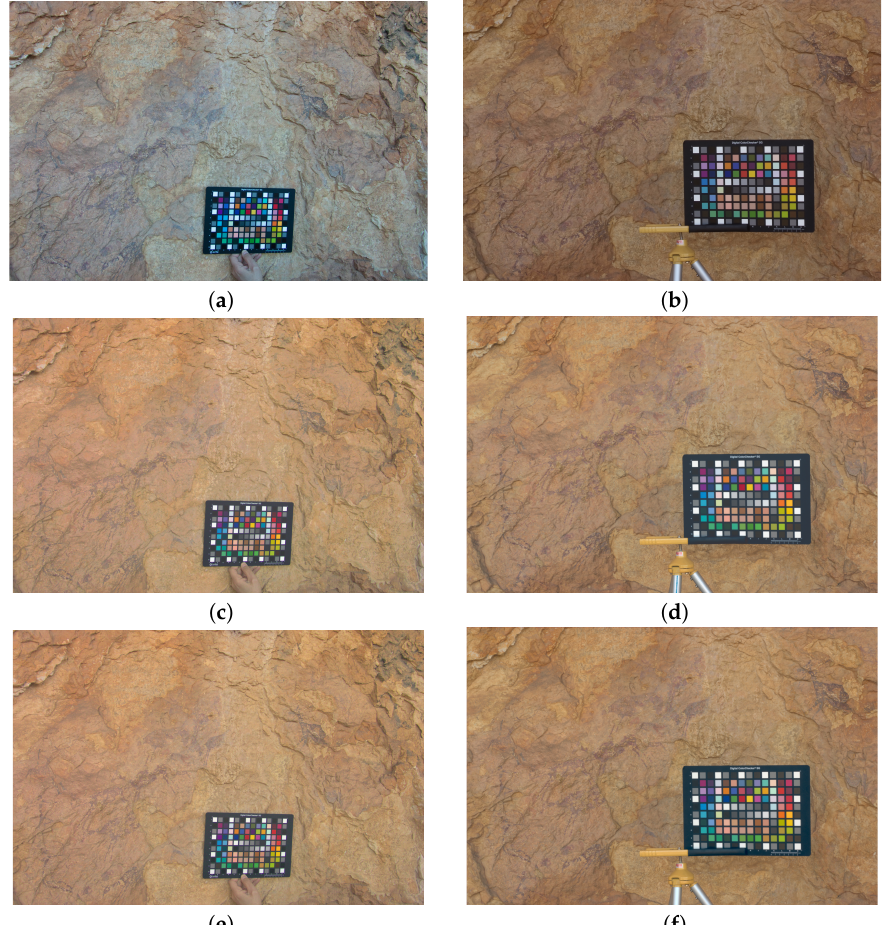
Figure 8. Original and output sRGB characterized images: ( a , c , e ) Sigma SD15; ( b , d , f ) Fujifilm IS PRO; ( a , b ) Original; ( c , d ) GP; ( e , f ) Second-order polynomial